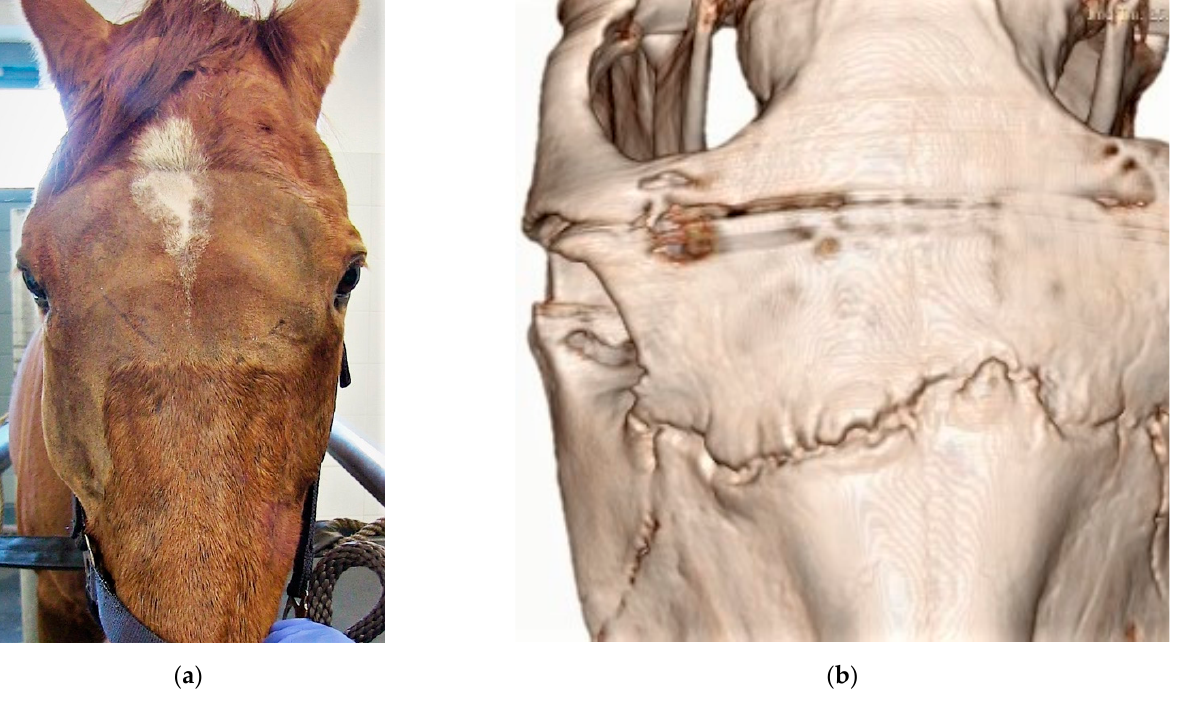
Figure 10. a , b : Clinical situation ( a ) and CT ( b ) reconstruction of a horses with bilateral, nearly sym- metric suture exostosis, starting at one side, advancing along the suture lines to the contralateral side.